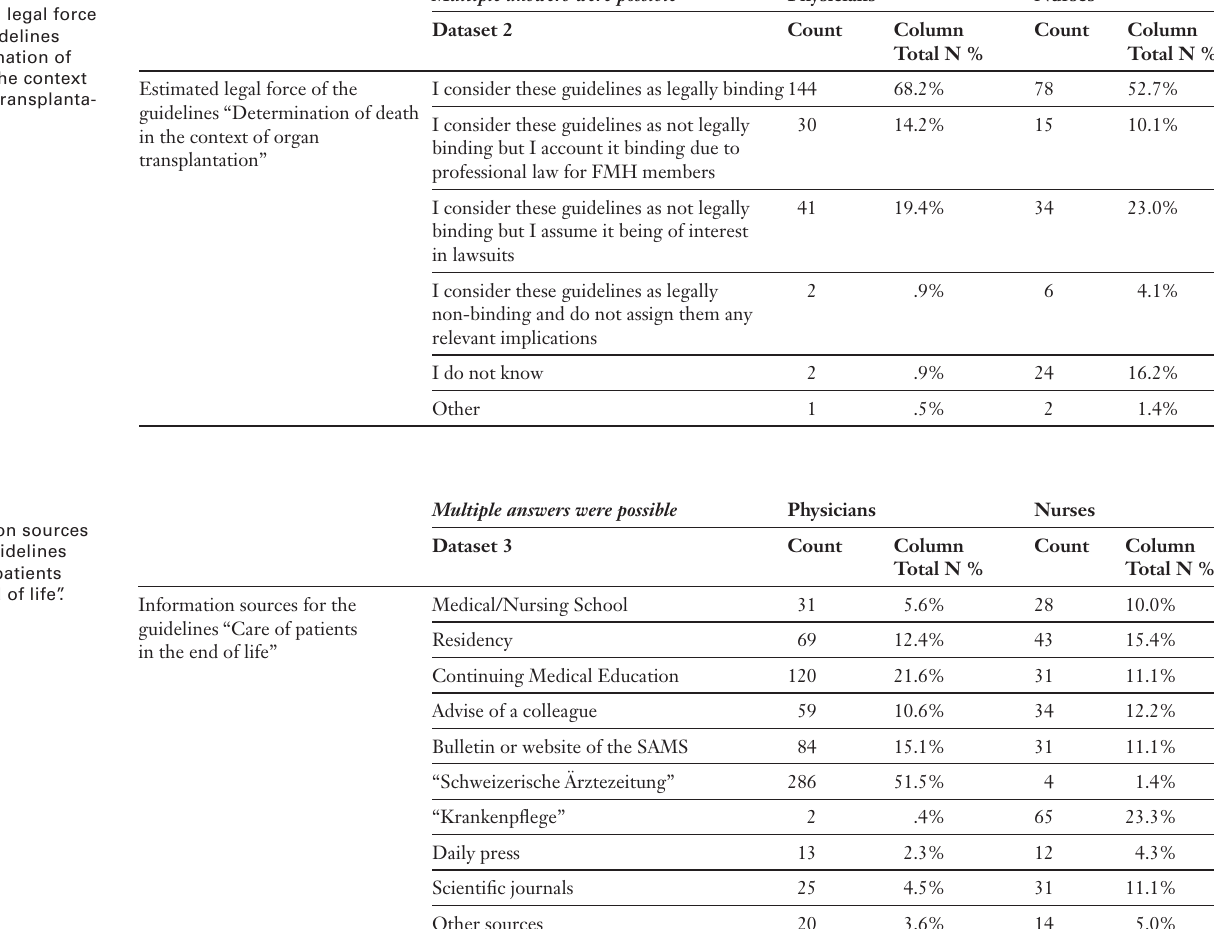
Estimated legal force of the guidelines “Determination of death in the context of organ transplanta- tion”.